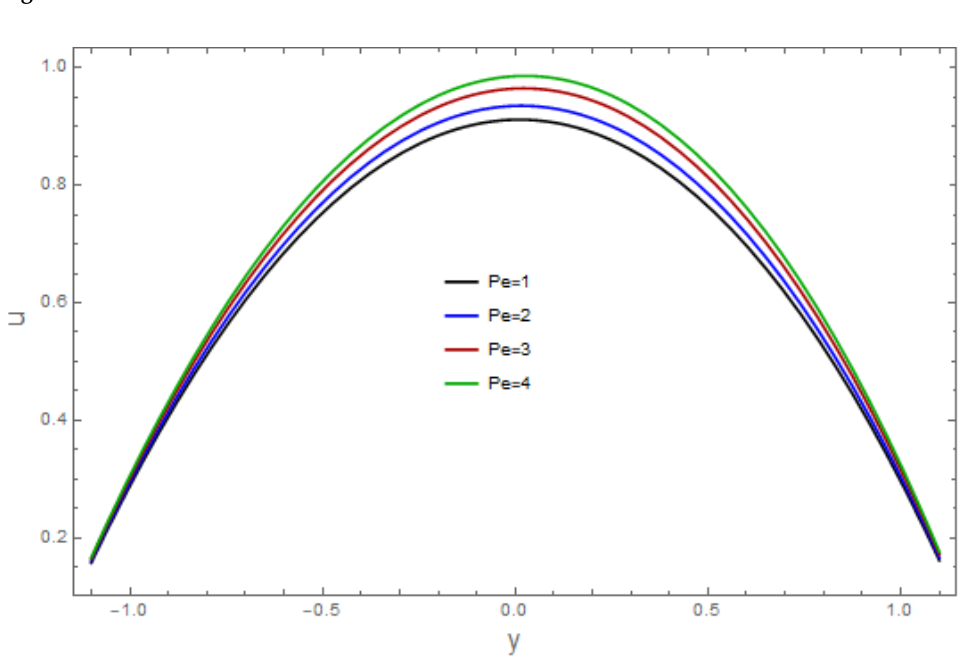
Figure 6. Effect of 𝑃𝑒 on 𝑢 .